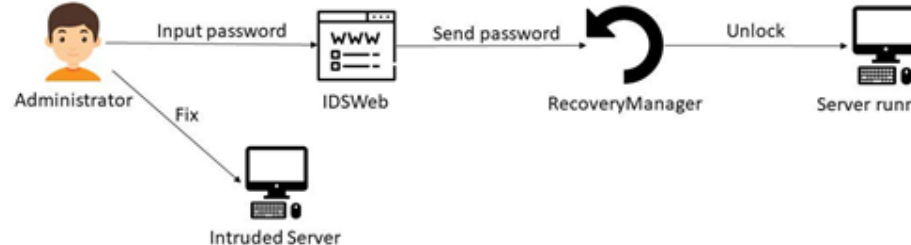
Figure 24. Diagram of the unlock process.